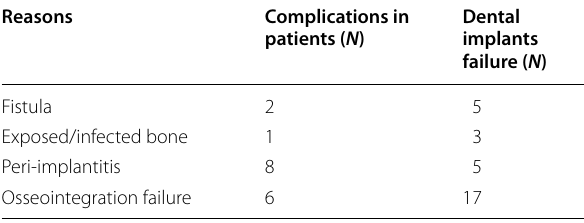
Table 2 Complications associated with implant failure